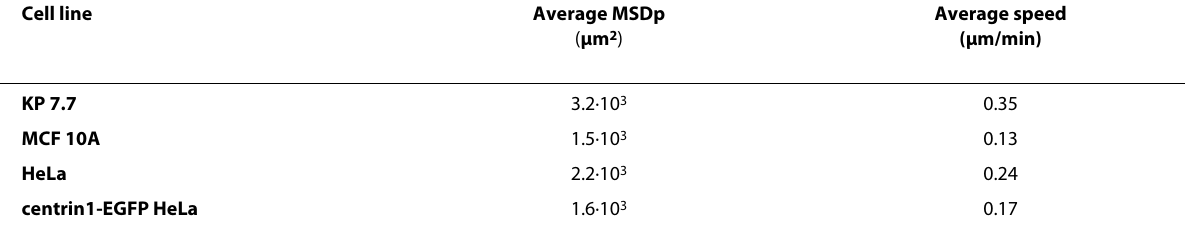
Table 1: Centriole mobility during cytokinesis of various mammalian epithelial cell lines Cell line